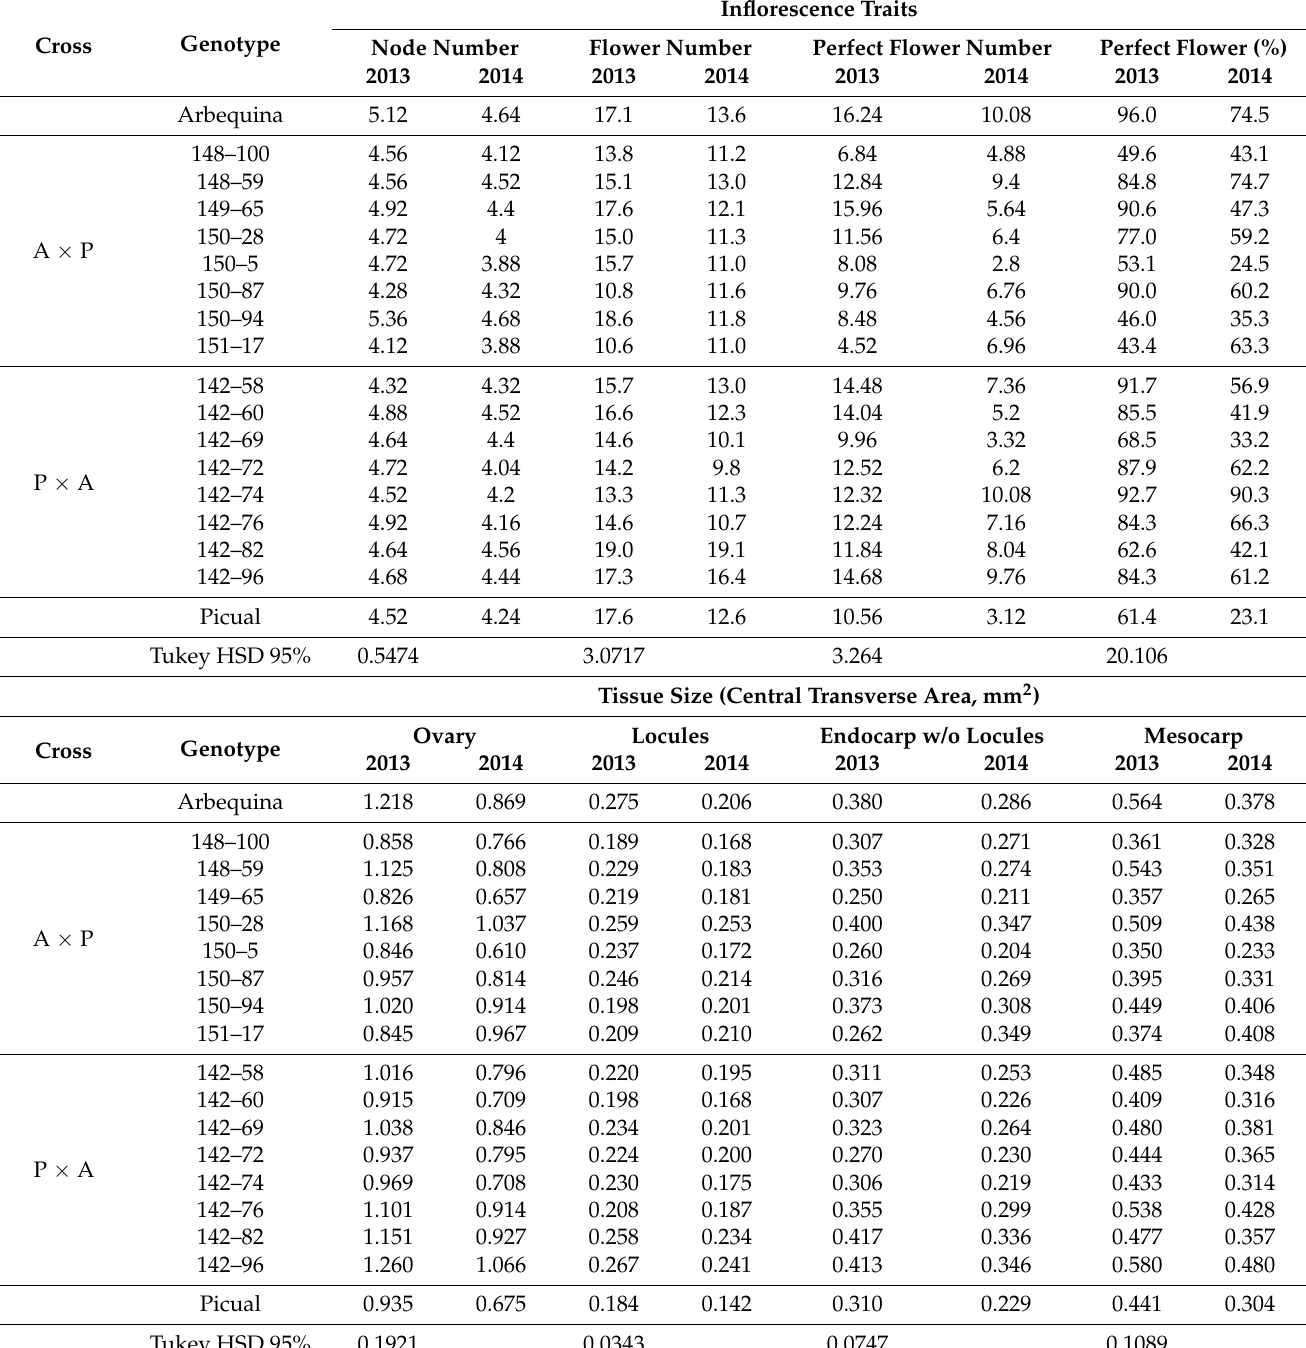
Table 3. Average values by genotype and year for the evaluated inflorescence and ovary